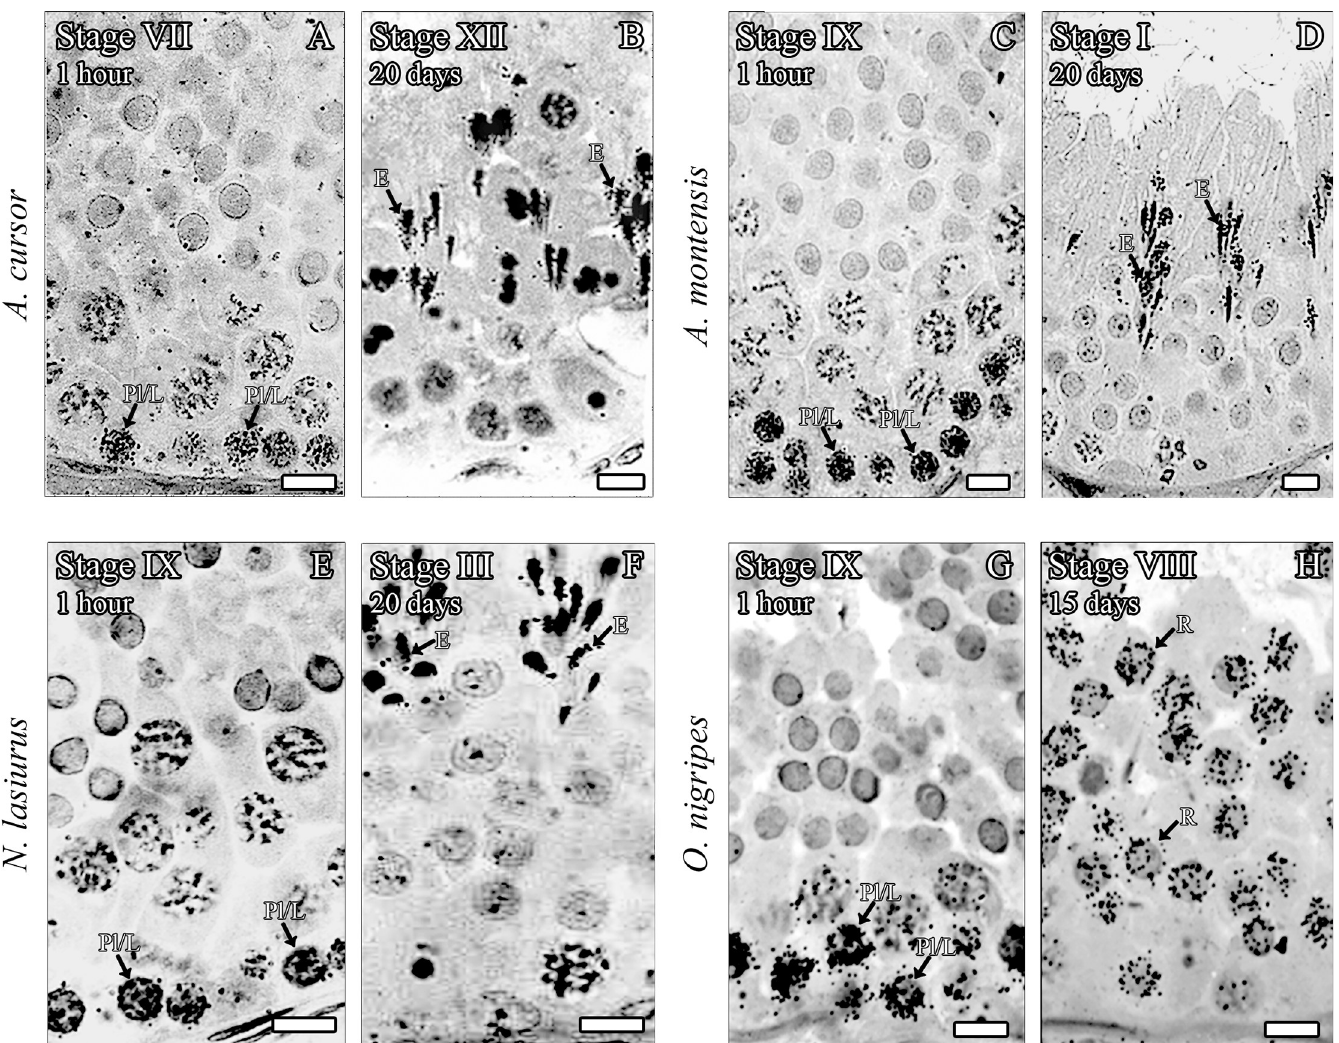
Fig 2. Evaluation of tritiated thymidine labeling. The most advanced germ cell type labeled (arrows) at different time periods (1 hour, 15 and 20 days) in A . cursor (A and B), A . montensis (C and D), N . lasiurus (E and F) and O . nigripes (G and H), after intratesticular tritiated thymidine injections. Bar = 10 μ m. Abbreviations: pre- leptotene in the transition to leptotene spermatocytes (Pl/L); round spermatids (R); and elongating/elongated spermatids (E).